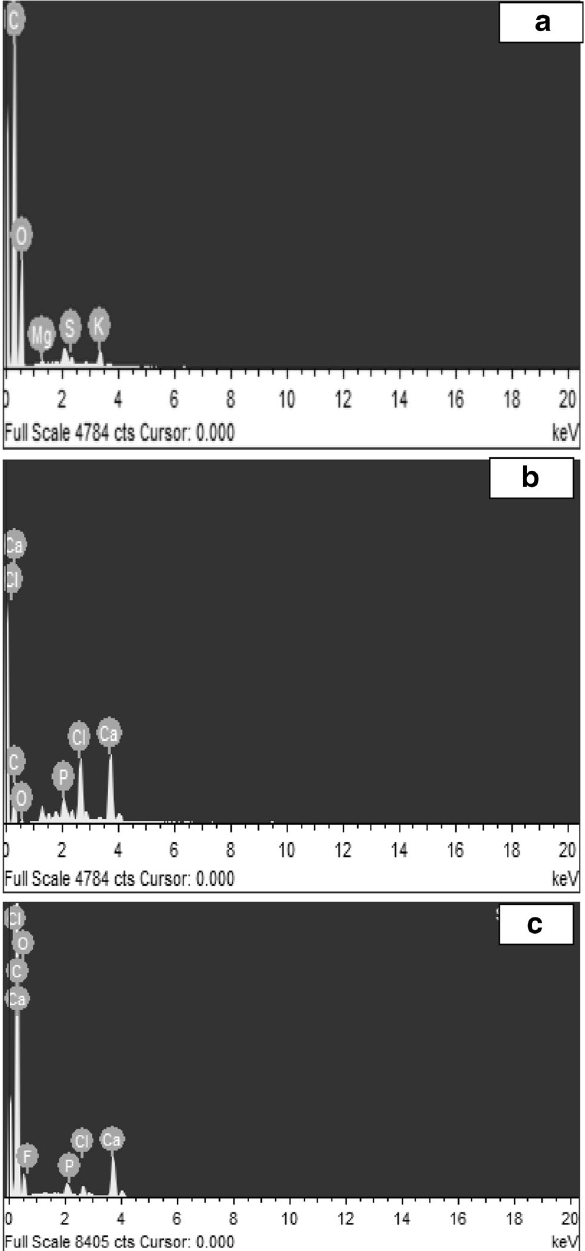
Fig. 3 EDX of a SFP, b CCSFP and c fluoride-loaded